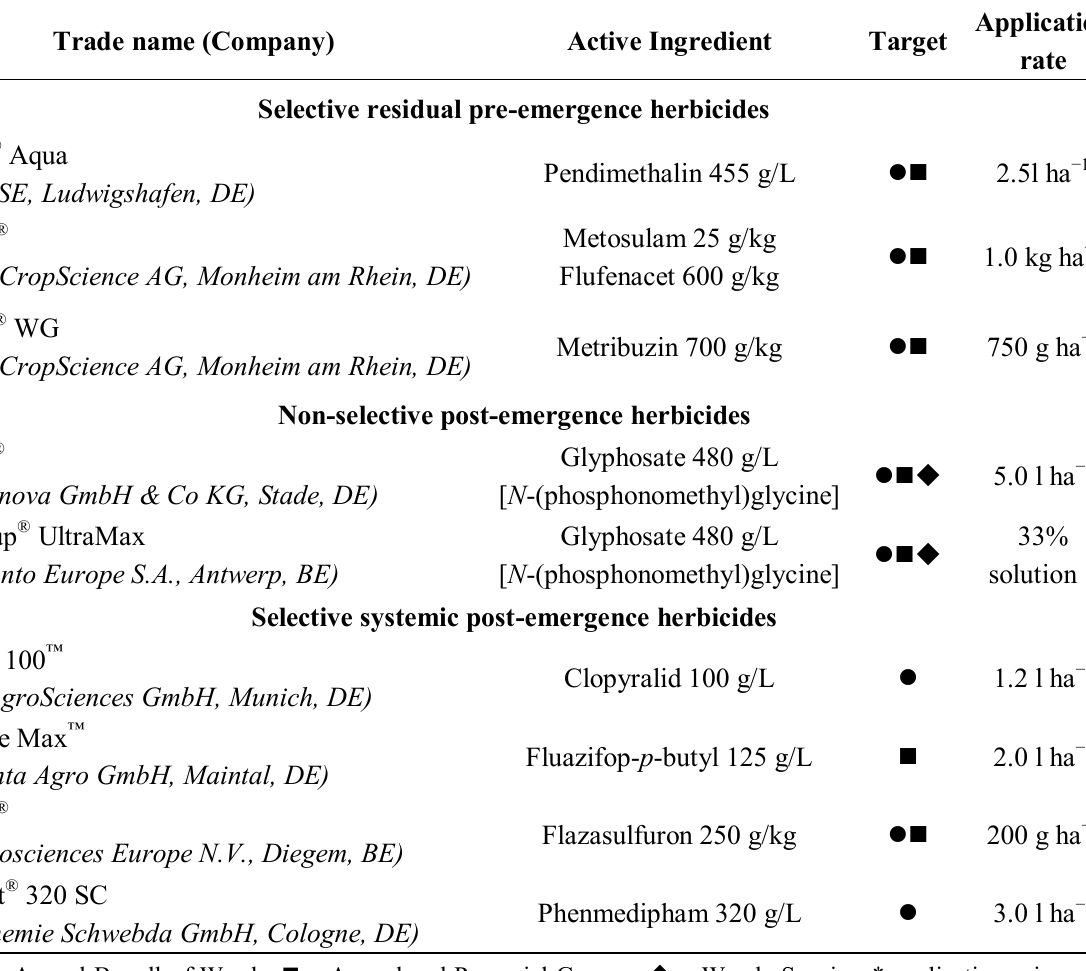
Table 2. Herbicides and their active ingredients used in this study.